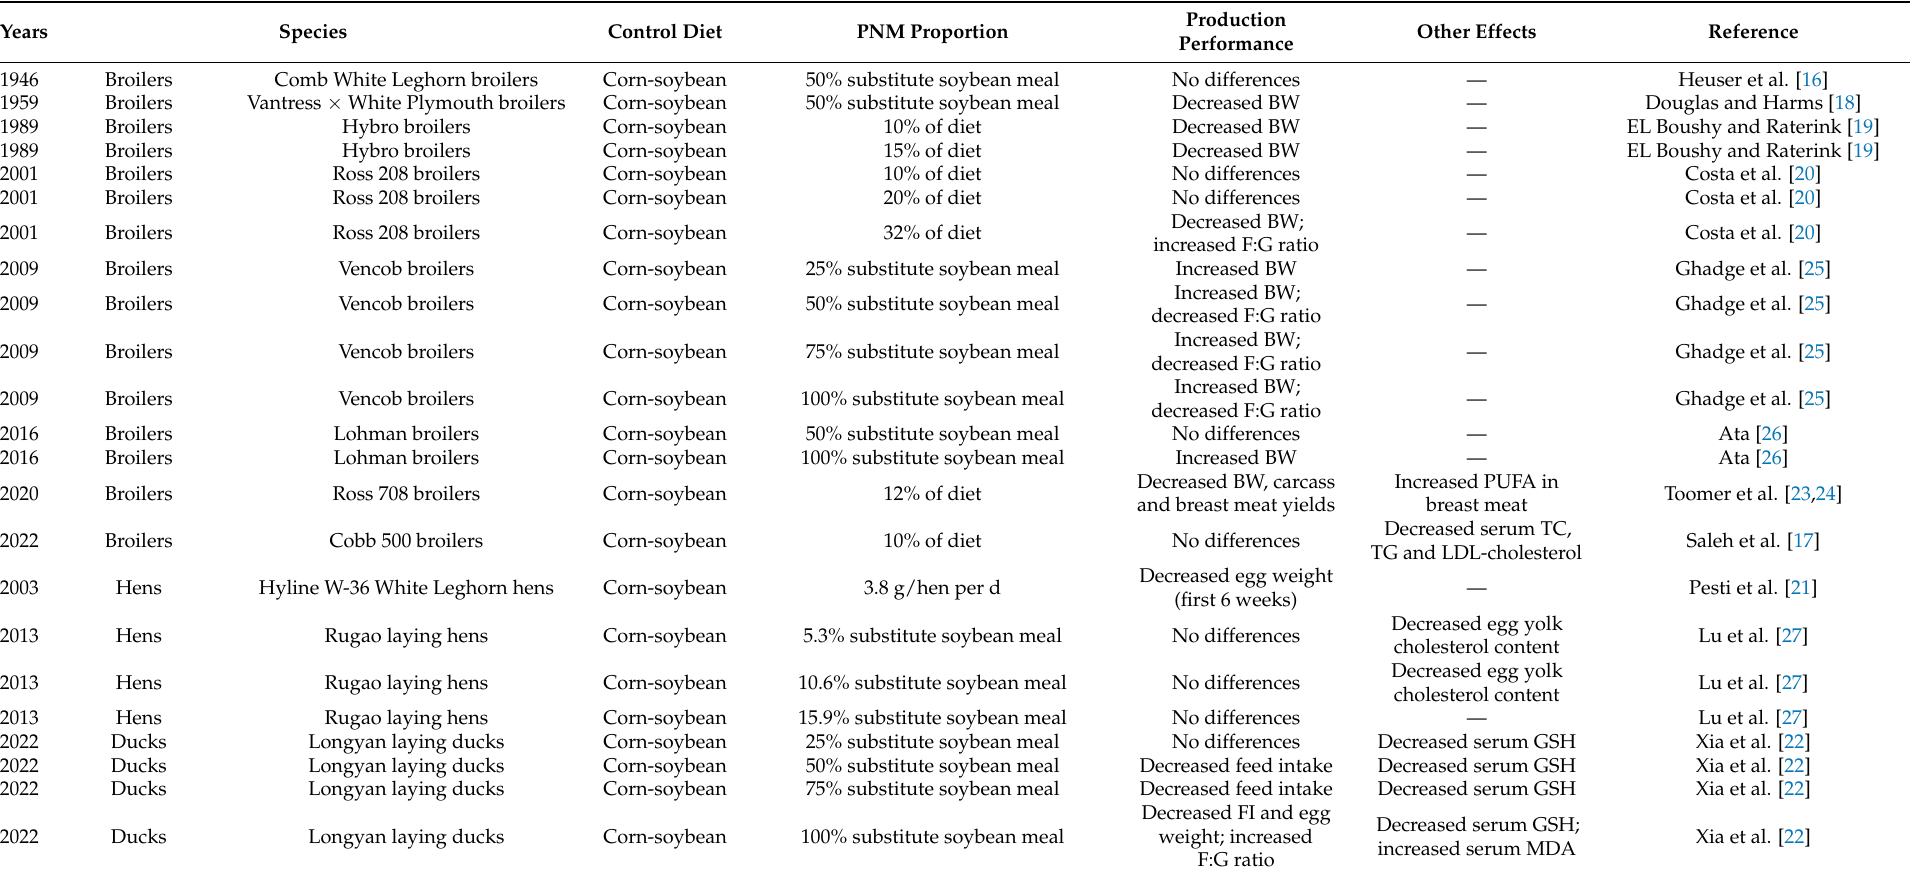
Table 1. List of the effects of PNM on the production performance of